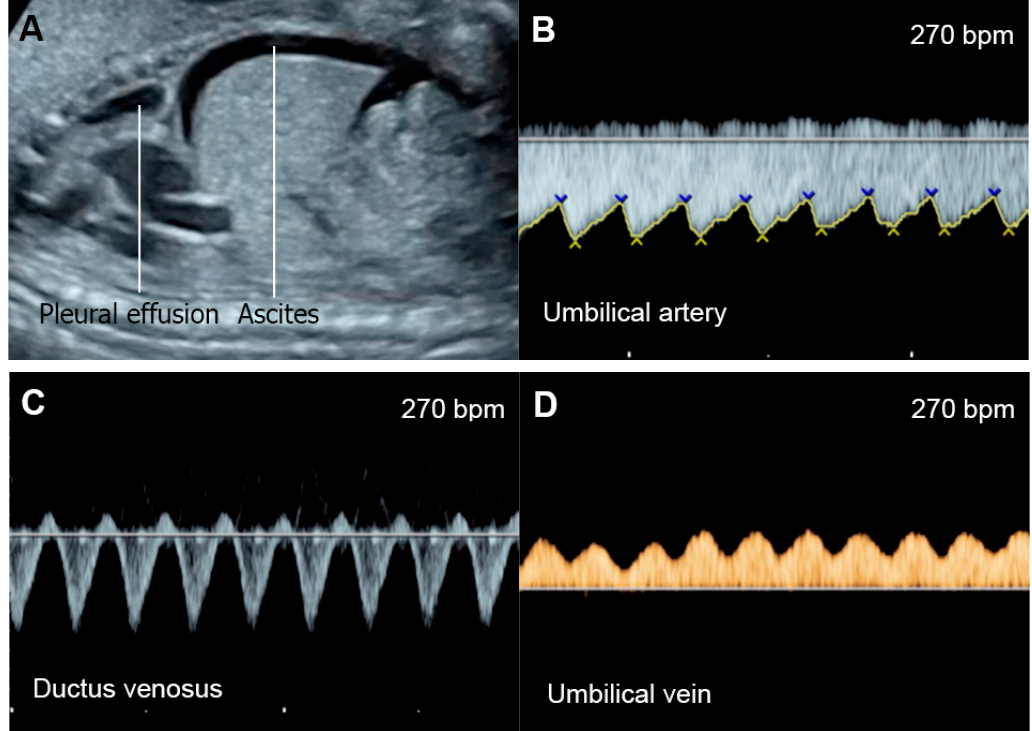
Figure 2. Supraventricular tachycardia: ( A ) hydropic signs; ( B ) high end-diastole velocity due to rapid heart rate; ( C ) ductus venosus Doppler: reversed A-wave, no D-wave due to rapid heart